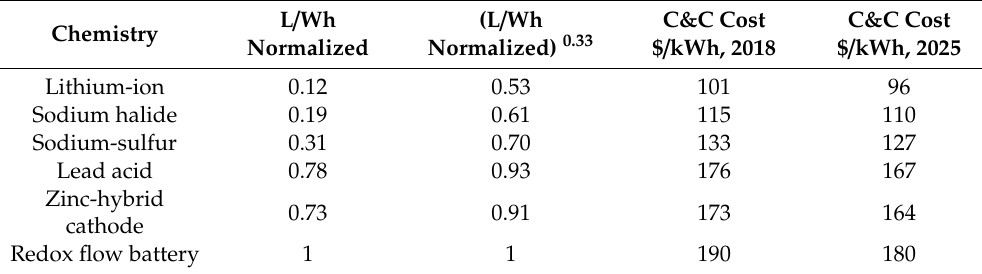
Table 3. C&C Cost by Technology ($ / kWh), 2018 and